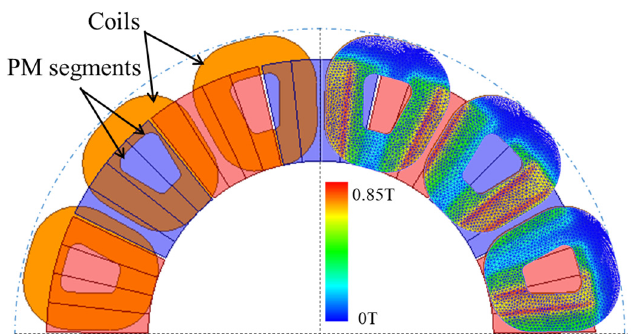
Figure 6. Phase vector of the six-phase winding arrangement.